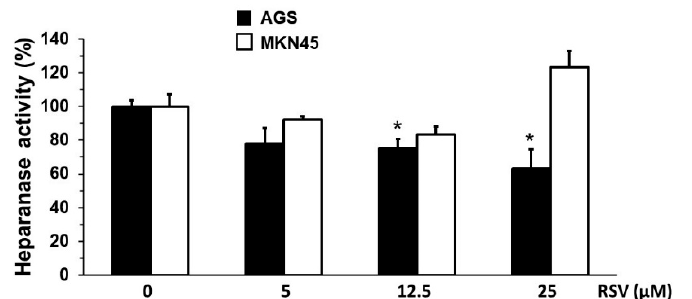
Figure 5. Effect of RSV on the heparanase activity of gastric cancer cell lines. AGS and MKN45 gastric cancer cells were treated with different concentrations of RSV (5, 12.5, and 25 µ M) for 24 h. Heparanase activity was measured using biotinylated heparan sulfate as a substrate. Bars represent the percentage of enzymatic activity in AGS (black column) and MKN45 (white column) following RSV treatment compared to the ethanol-treated cells (control 100%). Values represent the means ± S.D. from triplicate experiments. * p < 0.05 vs. control.